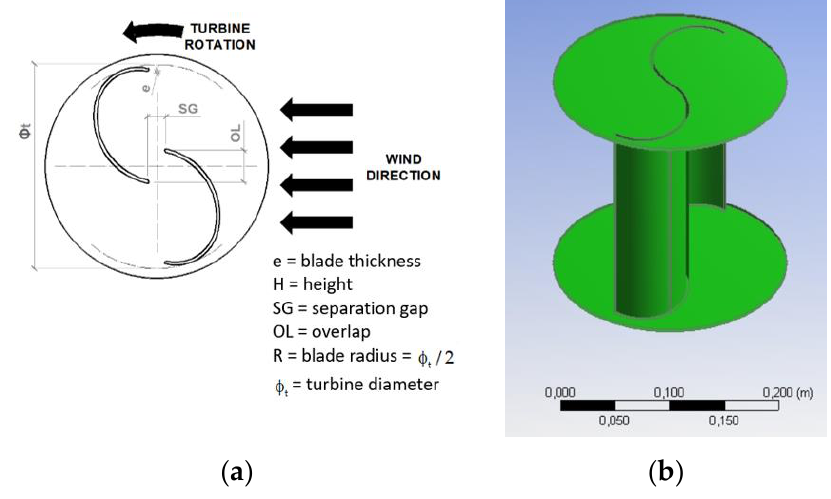
Figure 3. ( a ) Constructive parameters; ( b ) 3D model.